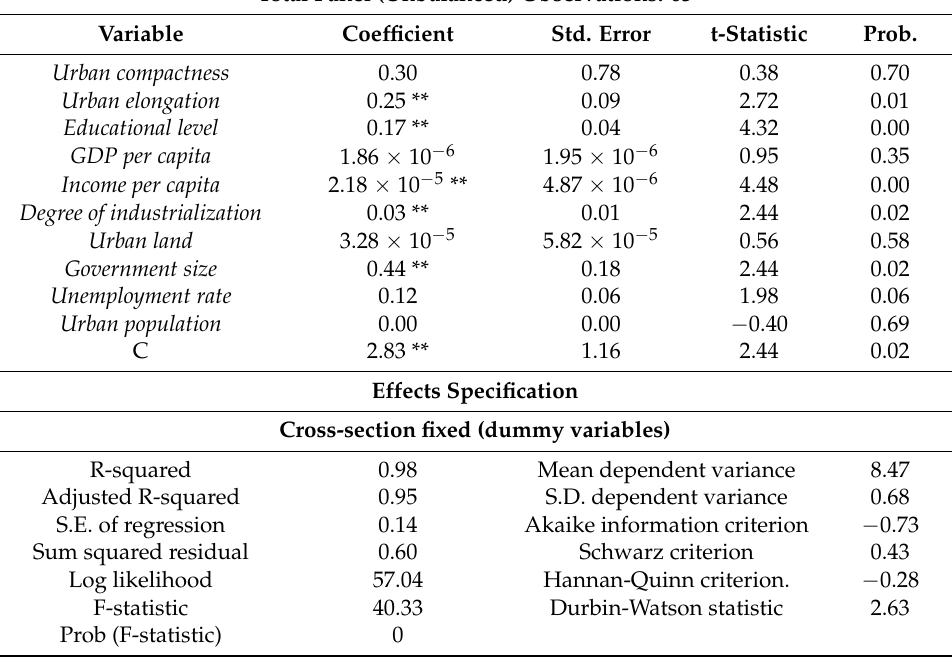
Table 8. Results of panel data